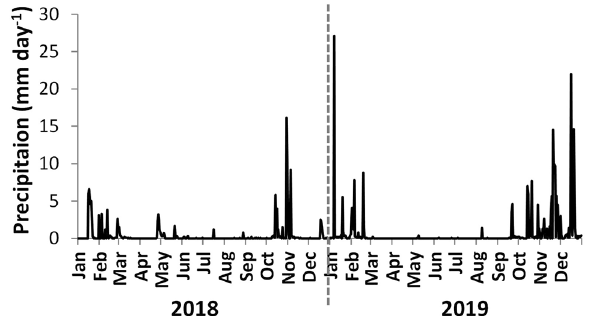
Figure 3. Daily time series of precipitation measured in the Sado Estuary region in the meteorological station of “Montevil” (mm day −1 , https:// snirh. apamb iente. pt/).